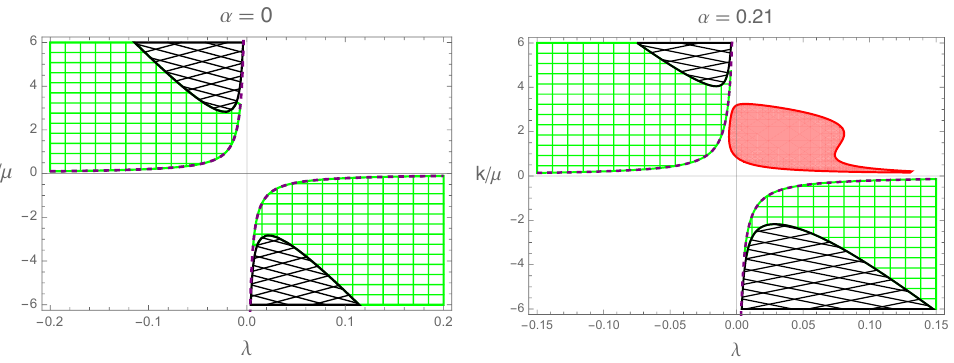
= 0 : 088 at (cid:21) = 0 : 029 : For (cid:12)xed (cid:21) , when min